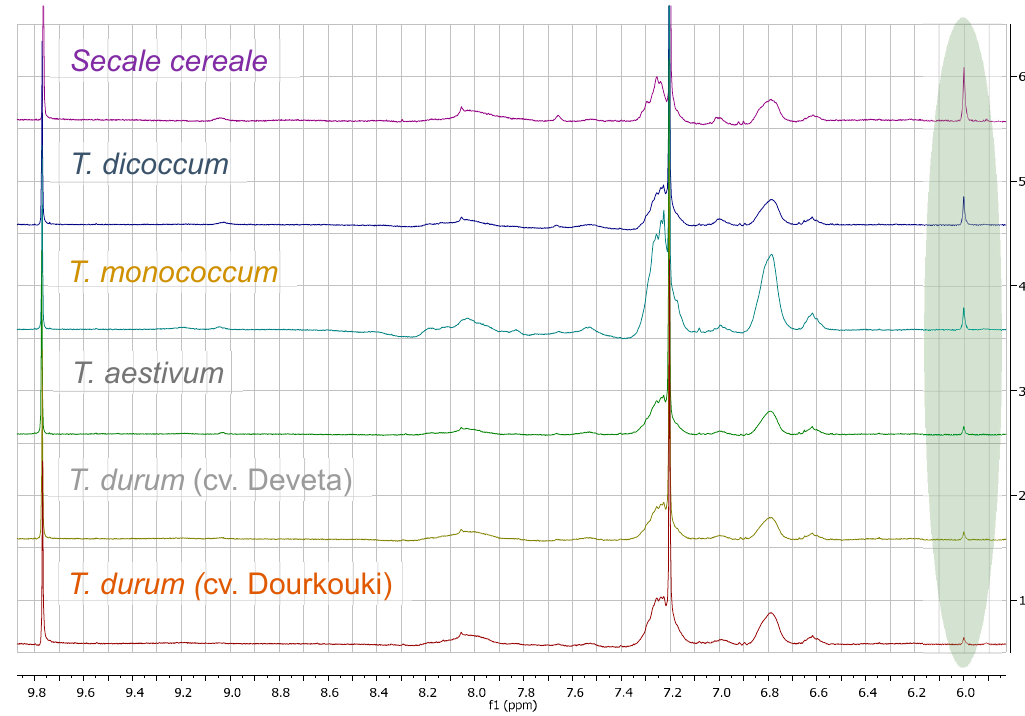
Figure A7 . 1 H-NMR spectra in d 6 -DMSO of extracts of grains showing the ARS peak.